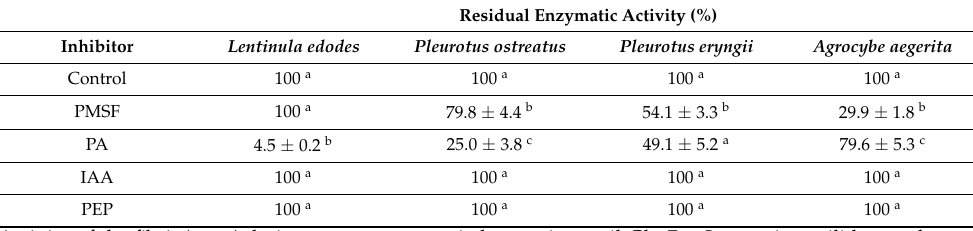
Table 3. Effect of protease inhibitors on fibrin(ogen)olytic enzymes of crude